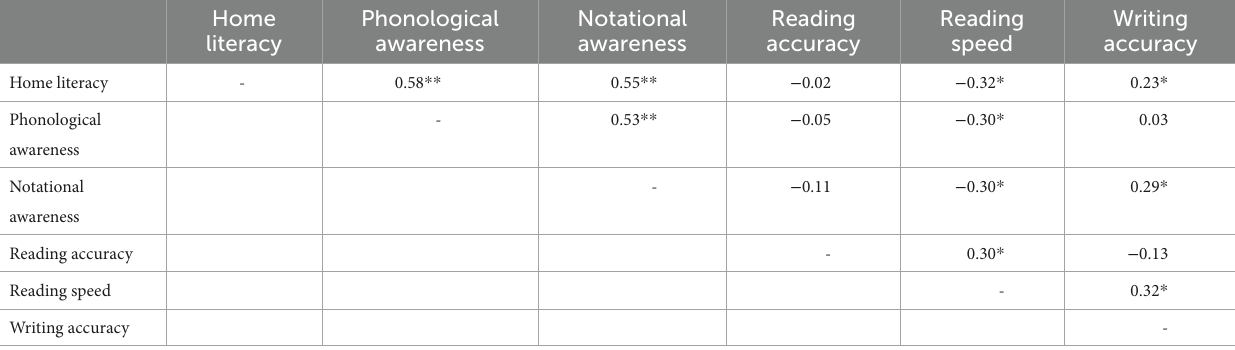
TABLE 2 Pearson’s correlational bivariate